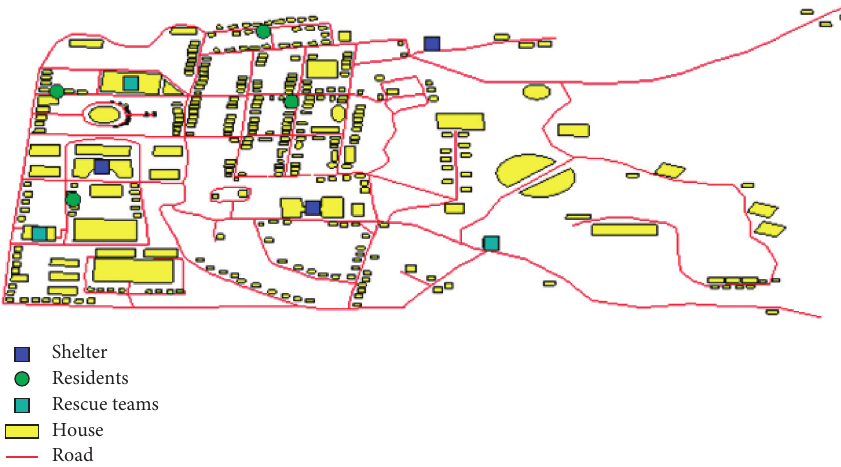
Figure 2: Initial display of rainstorm disaster simulation using Repast.